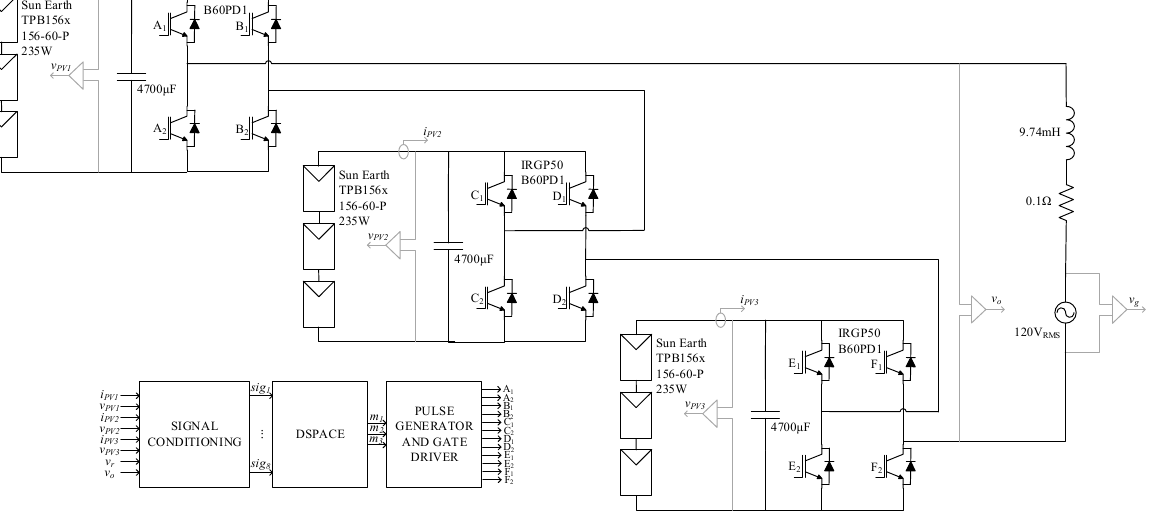
Figure 7. General schematic for the implemented prototype. Table 2. System and PV panel electrical parameters.